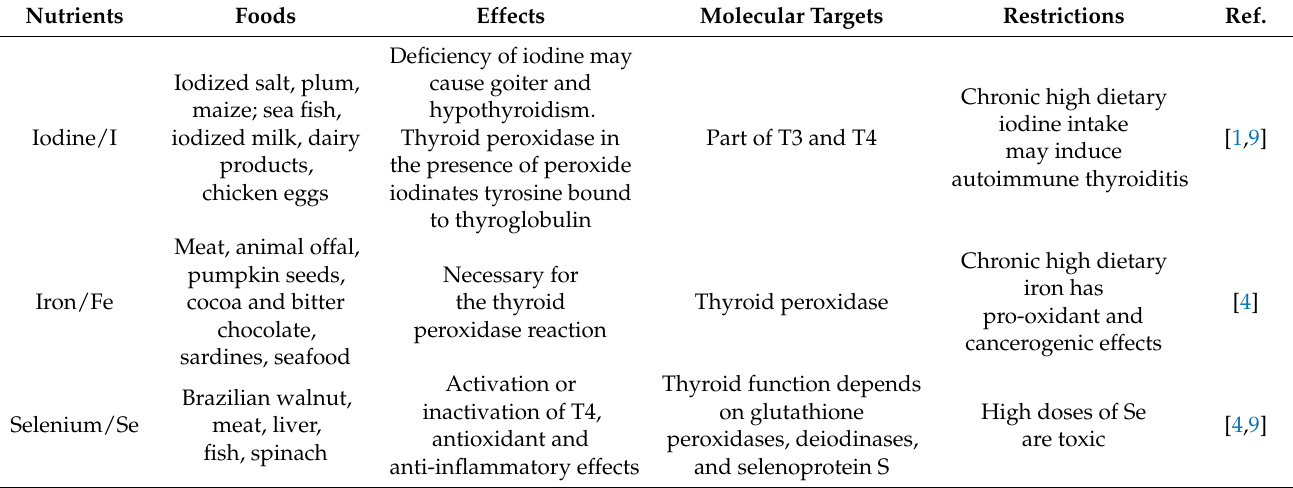
Table 1. Deficits or excess of nutrients and their effects on thyroid gland